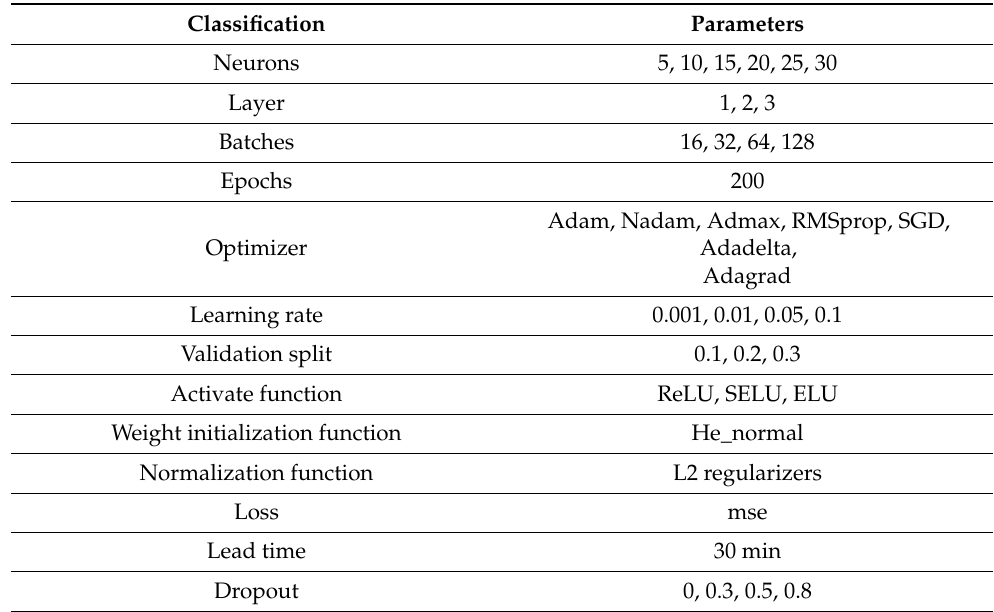
Table 4. Hyperparameter estimation by the random search